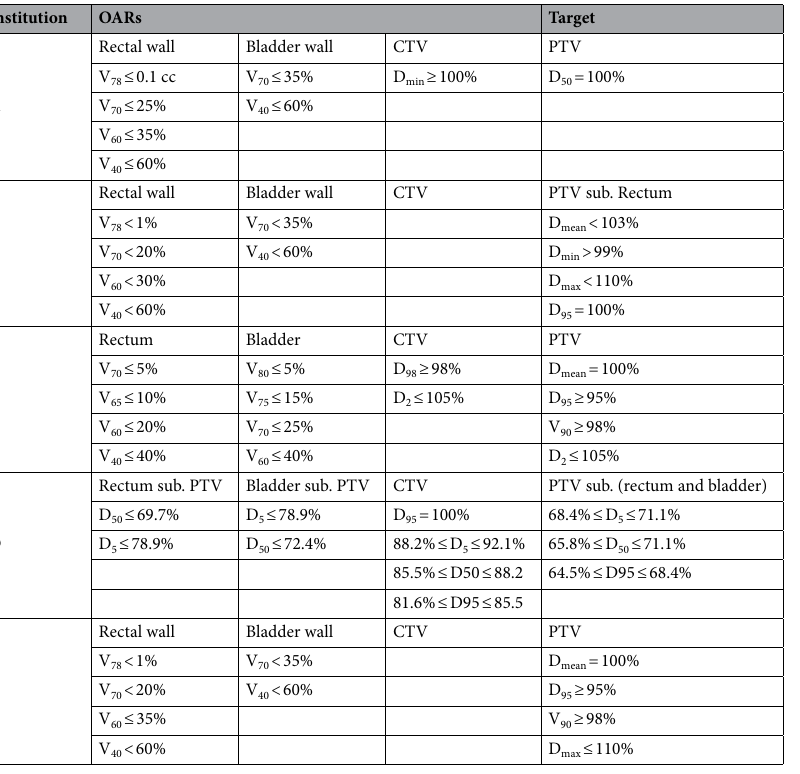
Table 1. Dose constraints at each institution. CTV Clinical target volume; PTV Planning target volume; D mean Mean dose; D min Minimum dose; D max Maximum dose; V 80 , V 78 , V 70 , V 65 , V 60 , and V 40 , Organ at risk (OAR) volume ratio receiving doses exceeding 80 Gy, 78 Gy, 70 Gy, 65 Gy, 60 Gy, and 40 Gy, respectively; V 90 , Volume ratio receiving 90% of the prescribed dose; D 95 , D 50 , D 5 , and D 2 , Dose received by at least 95%, 50%, 5%, and 2% of the volume,